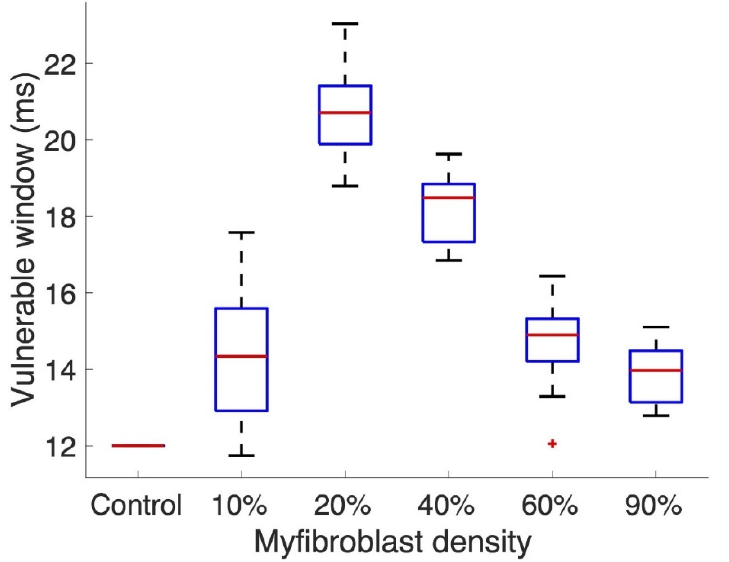
Figure 7. Tissue vulnerable window for all myofibroblast infiltration patterns. Vulnerability to ar- rhythmia increased for all patterns. Outliers are marked with a plus (+) on the boxplot.